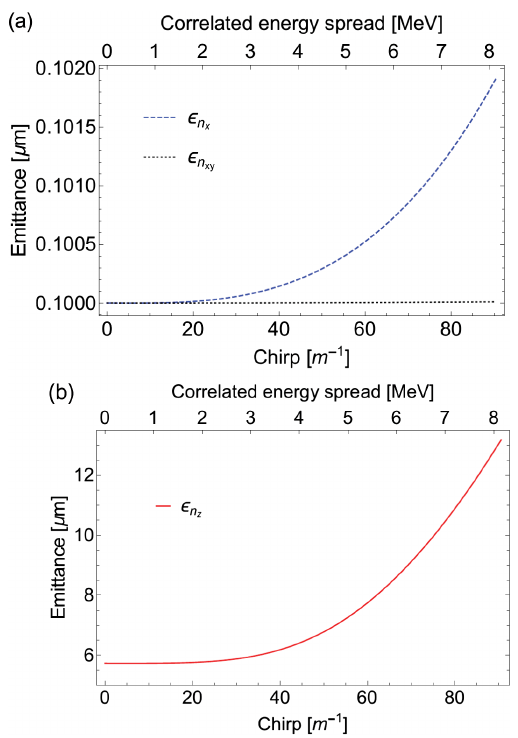
FIG. 10. (a) Transverse and (b) longitudinal emittances at the exit of the optimized TCBC at 1 GeV versus the applied chirp.